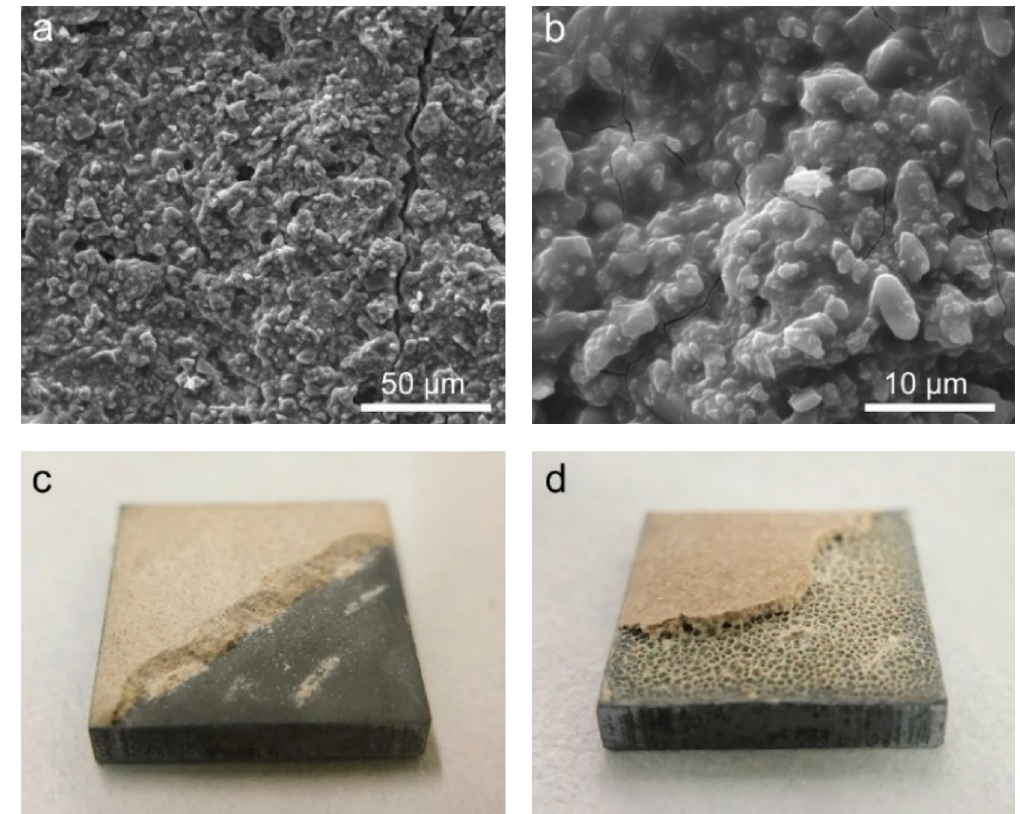
Figure 3. ( a , b ) Scanning electron micrographs and ( c ) photograph of an MPC coating [6% of dead-burned magnesia replaced with Mg(OH)